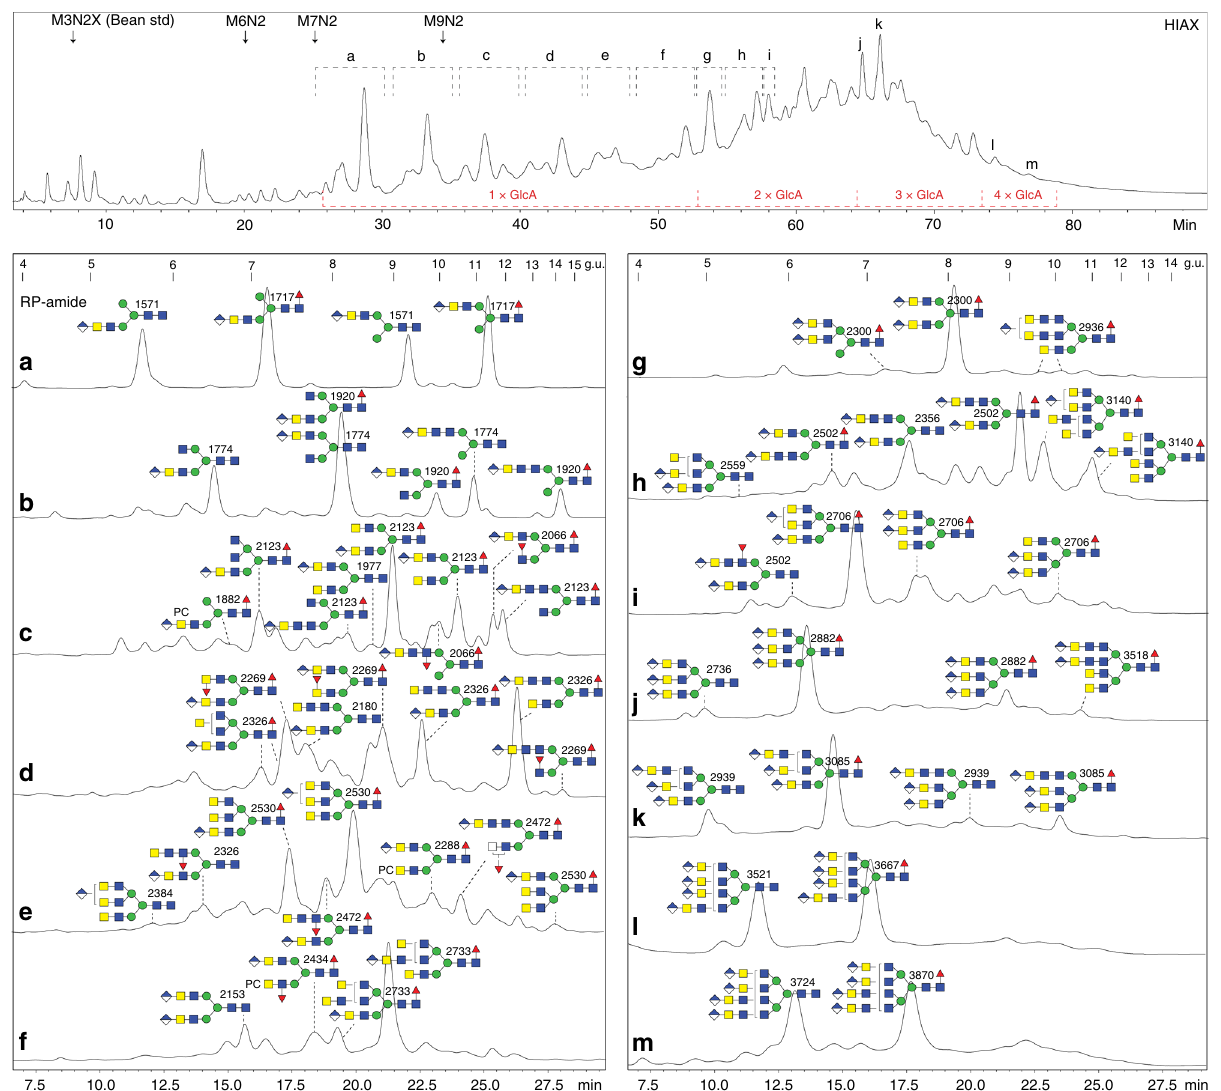
Fig. 5 Two-dimensional HPLC fractionation of Diro fi laria immitis anionic N-glycans. As for the neutral preparations, the pyridylaminated N-glycans were separated by HIAX as calibrated with a set of glycans from white beans (Man 3 GlcNAc 2 Xyl 1 and Man 6-9 GlcNAc 2 ) and detected by fl uorescence. Indicated are pooled regions whose second-dimension RP-amide HPLC pro fi les (normalised in terms of fl uorescence) are shown in a – m as well as the regions in which mono-, di-, tri- and tetra-glucuronylated glycans elute from the HIAX column in a size- and charge-dependent manner. The RP-amide HPLC chromatograms, calibrated in terms of glucose units (g.u.), are annotated with glycan structures according to the Standard Nomenclature for Glycans (mannose is depicted by green circles, GalNAc/GlcNAc by yellow or blue squares, fucose by red triangles, glucuronic acid by diamonds and phosphorylcholine by PC) as well as the m / z for the [M + H] + ions as detected by MALDI-TOF – MS; the depicted structures are based on conclusions derived from RP-amide elution time, chemical and/or enzymatic digestion and MS/MS data of which a selection is shown in Figs. 6 – 8 and Supplementary Figures 12 – 15. Overall MALDI-TOF – MS and 1D-HPLC pro fi les of an anionic glycan pool are shown in Supplementary Figures 2 and 11. Based on summed fl uorescence intensities as compared to the neutral chromatograms, it is estimated that 5% of the N-glycome is in the anionic pool